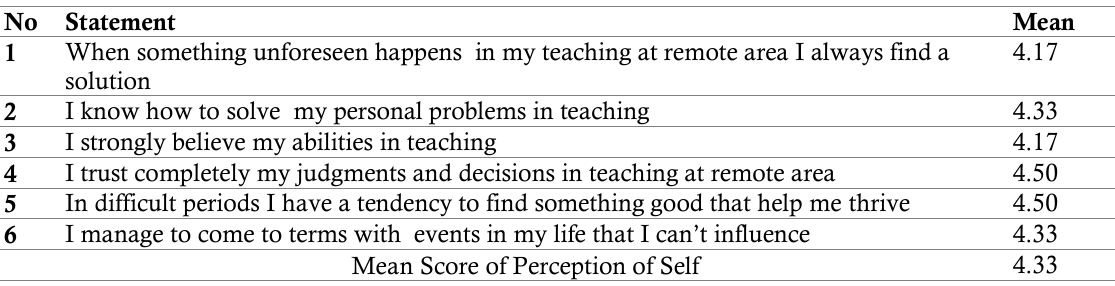
Table 1 . Personal Strength/Perception of Self